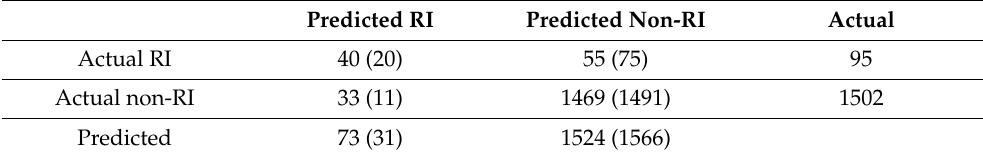
Table 5. Confusion matrix values after (before) hyperparameter tuning with the test data. Predicted RI Predicted Non-RI Actual Actual RI